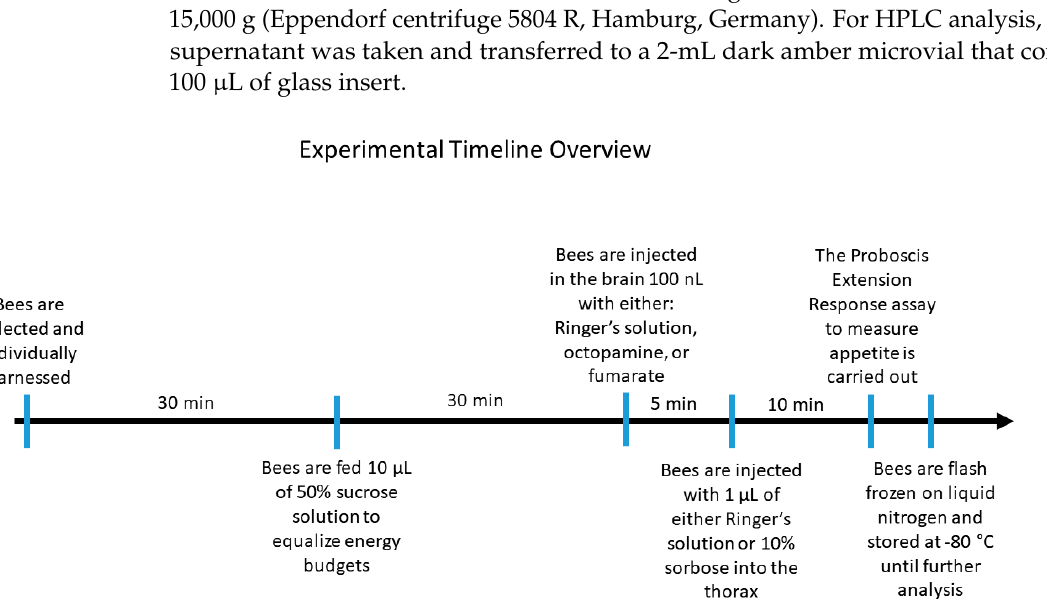
Figure 1. On overall timeline of the experimental procedure conducted with harnessed honey bees. The 10- and 5-min injection times were chosen based on when the maximum effect of the brain and thorax injections would be expected in relation to when the appetite was measured using the Proboscis Extension Response assay. The bees were fed with 10 µL of 50% sucrose solution to equalize their energy budgets at the start of the experiment.